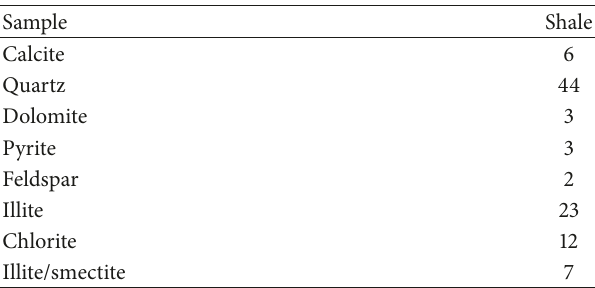
Table 1: Mineral concentrations (wt%) of the shale samples as determined by X-ray